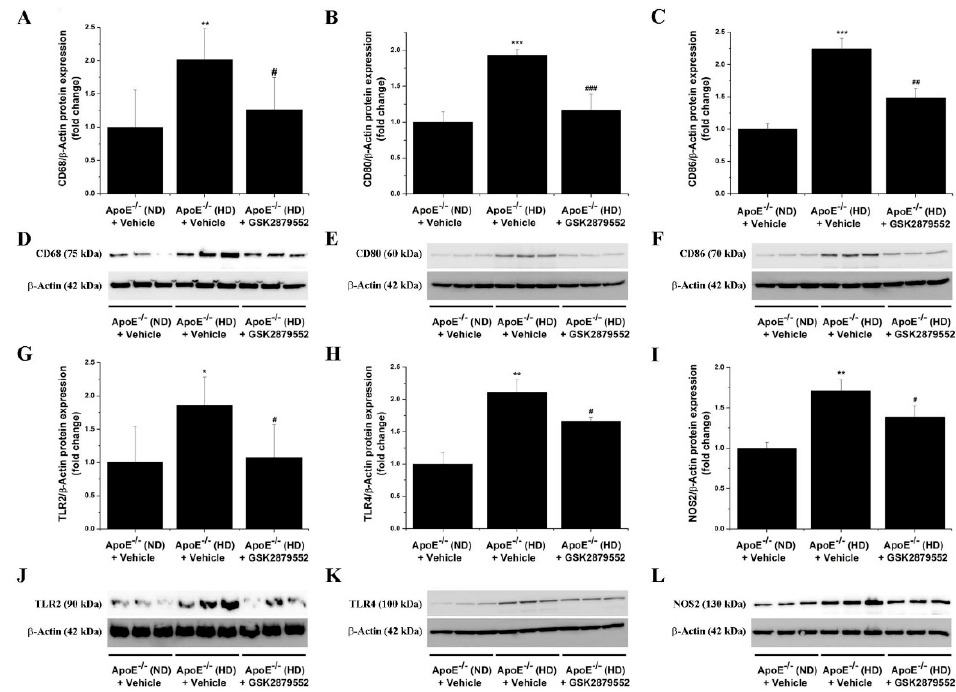
Figure 8. Pharmacological inhibition of LSD1 down-regulates the expression of markers of immune cells and inflammation in the atherosclerotic aorta of ApoE-/- mice. ( A –C, G – I ) Western blot assay-associated densitometric analysis showing the down-regulation of CD68, CD80, CD86, TLR2, TLR4, and NOS2 protein levels in the aorta of GSK2879552-treated ApoE-/- (HD) mice. ( D – F , J – L ) Representative immunoblots depicting the inhibitory effects of GSK2879552 treatment on the examined protein expression levels in the aorta of ApoE-/- (HD) mice. n = 3–6, * p < 0.05, ** p < 0.01, *** p < 0.001. p -values were taken in relation to vehicle-treated ApoE-/- (ND) condition. # p < 0.05, ## p < 0.01, ### p < 0.001. p -values were taken in relation to vehicle-treated ApoE-/- (HD)